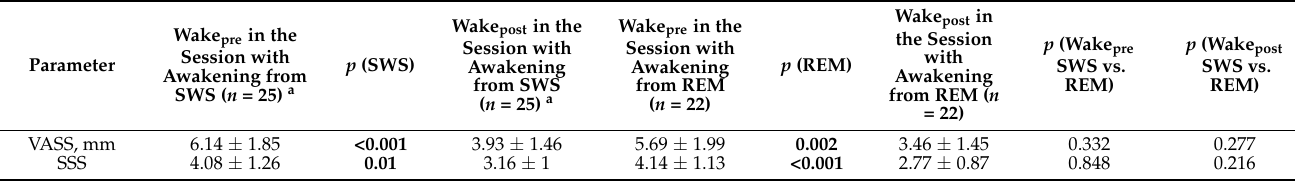
Table A4. Comparison of sleepiness assessment in Wake pre and Wake post in sessions with SWS and REM